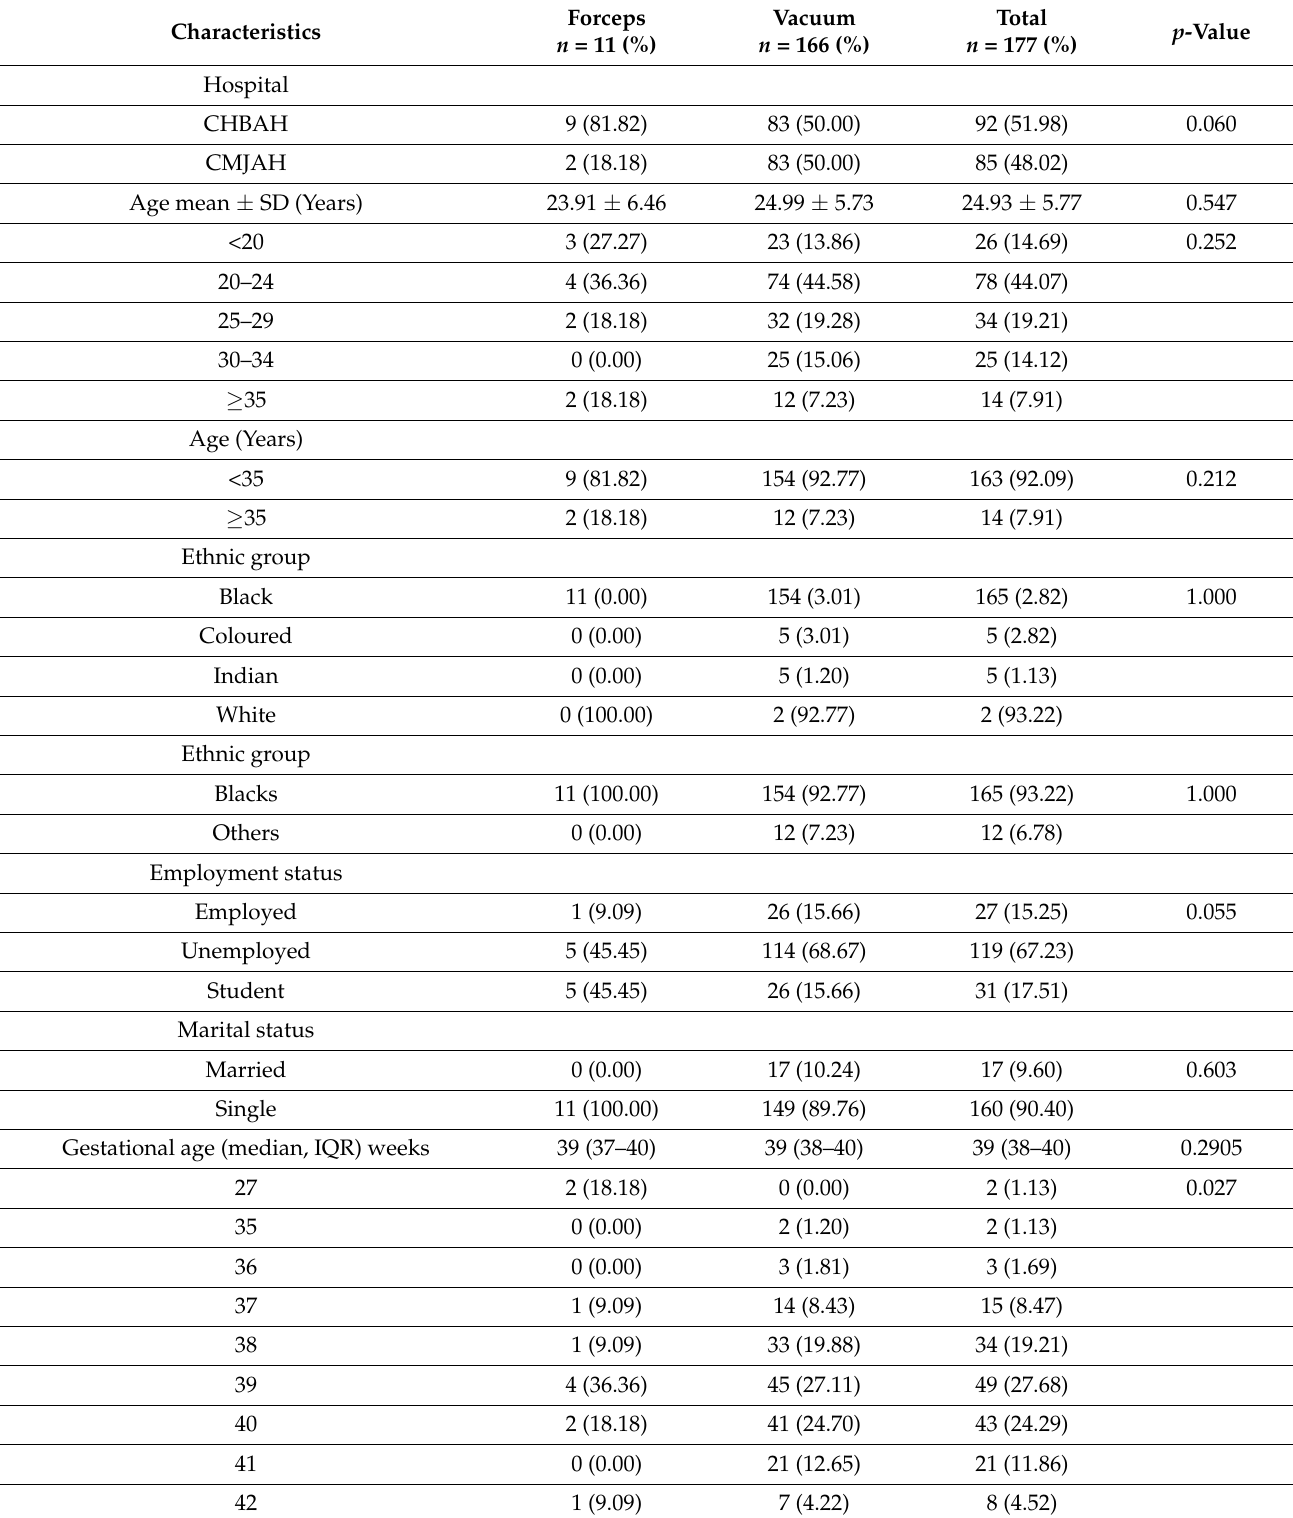
Table 4. Comparison of the sociodemographic and clinical characteristics among women that had forceps and vacuum